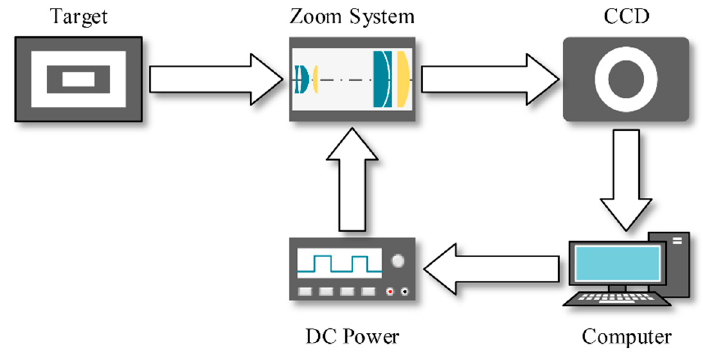
Figure 6. Structure of the experimental platform.